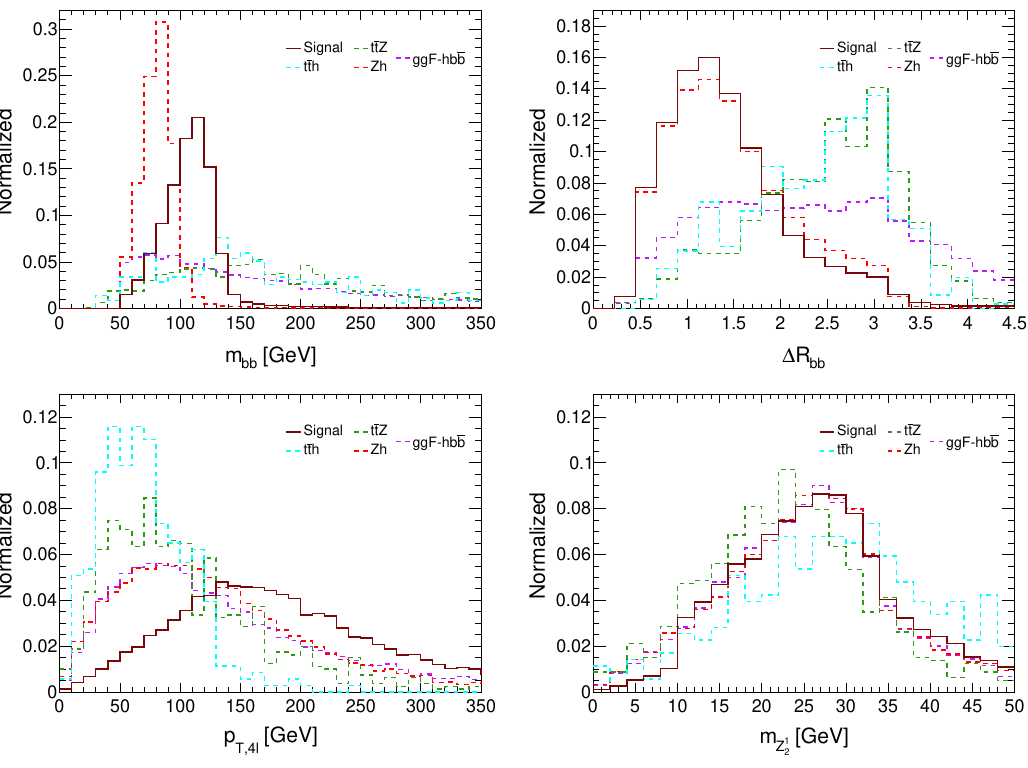
Figure 10 . Normalized distributions of m bb , ∆ R bb , p T, 4 ‘ and m 1 dominant backgrounds after the acceptance cuts and the generation level